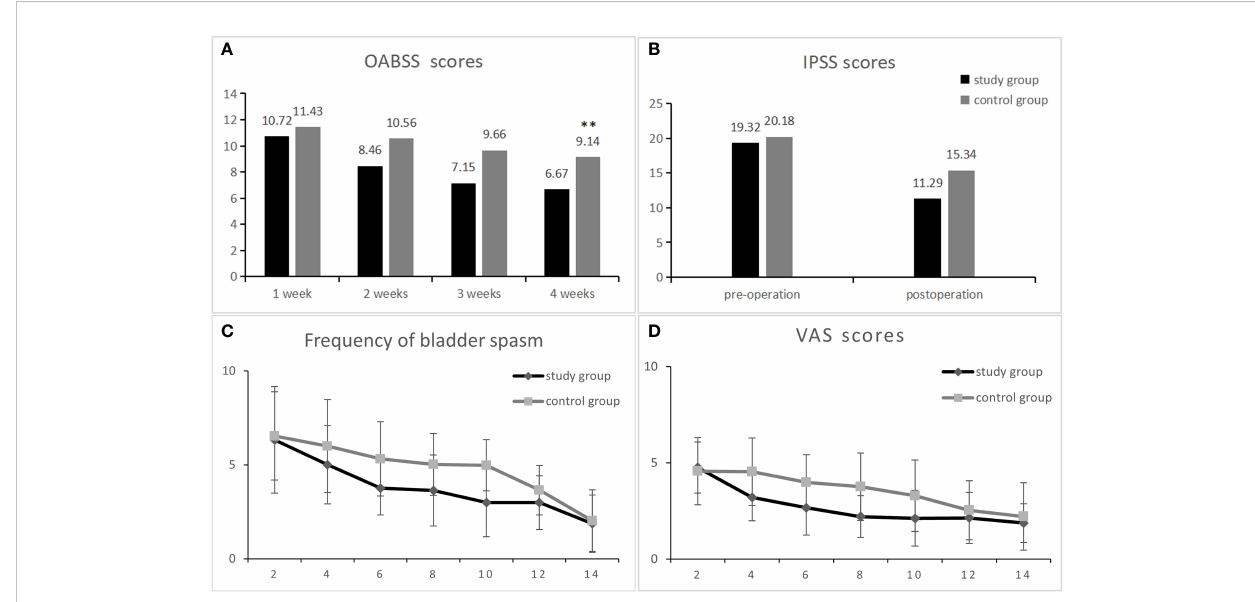
FIGURE 2 Comparison of data between the research group and the control group after surgery. OABSS scores at 1-4 weeks postoperatively in both groups (A) . Comparison of IPSS scores between the research group and the control group from 1 month pre-surgery and 1 month post-surgery (B) . The two groups of patients with bladder spasm and visual simulation scores (VAS) 2-14 days after surgery (C, D) ** represents a statistically signi fi cant